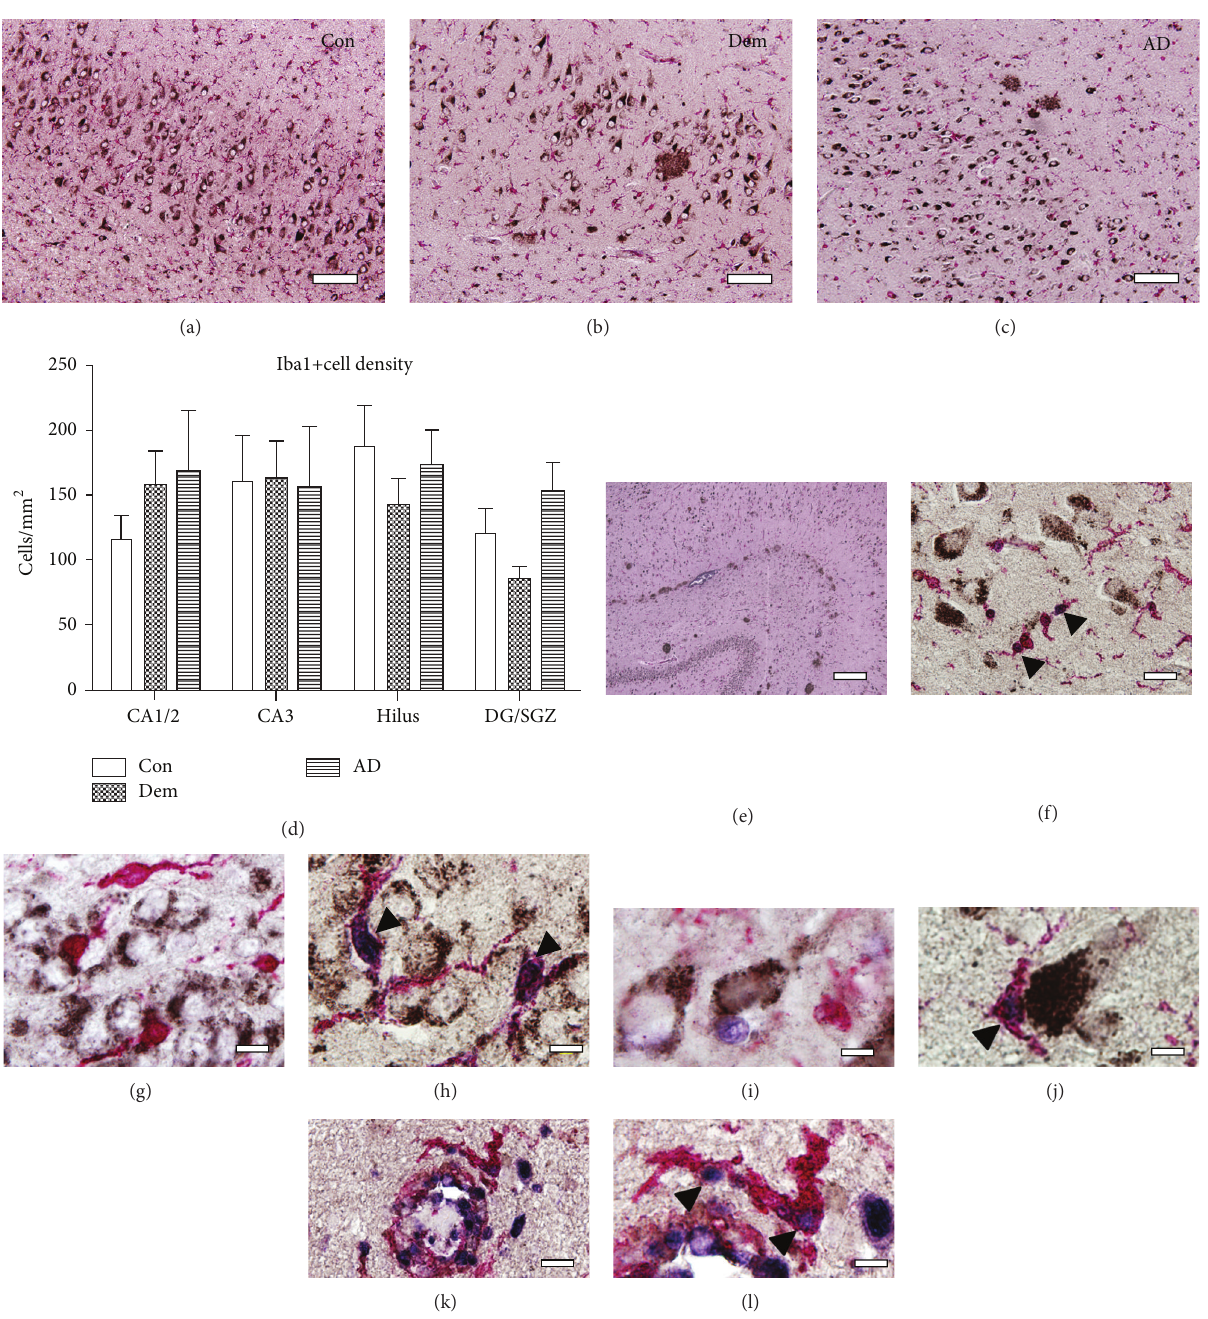
Figure 2: Iba1 morphology and proliferation in human hippocampus. (a–c) Representative images for Con, Dem, and AD subjects, respectively, illustrating a similar morphology of Iba1+ (red) cells. (d) Quantitative analysis of Iba+ cell density showed no significant difference between cohorts. Ramified Iba1+ cells throughout the hippocampus coexpress PCNA (arrowheads): (e) representative A 𝛽 and Iba1 distribution, (f) ramified and proliferating Iba1+ cells in the CA3 in the absence of A 𝛽 plaques, (g-h) in the GCL across patient cohorts, and (i-j) near pyramidal neurons expressing APP (black). (k-l) Positive control section from a brain infected with herpes simplex virus encephalitis (HSVE). Infected vessels show activated Iba1+ microglia and coexpression of PCNA (arrowheads). Scale bars (a–c) = 100 𝜇 m, (e) = 500 𝜇 m, (f) = 50 𝜇 m, (g–j) = 20 𝜇 m, (k) = 50 𝜇 m, and (l) = 20 𝜇